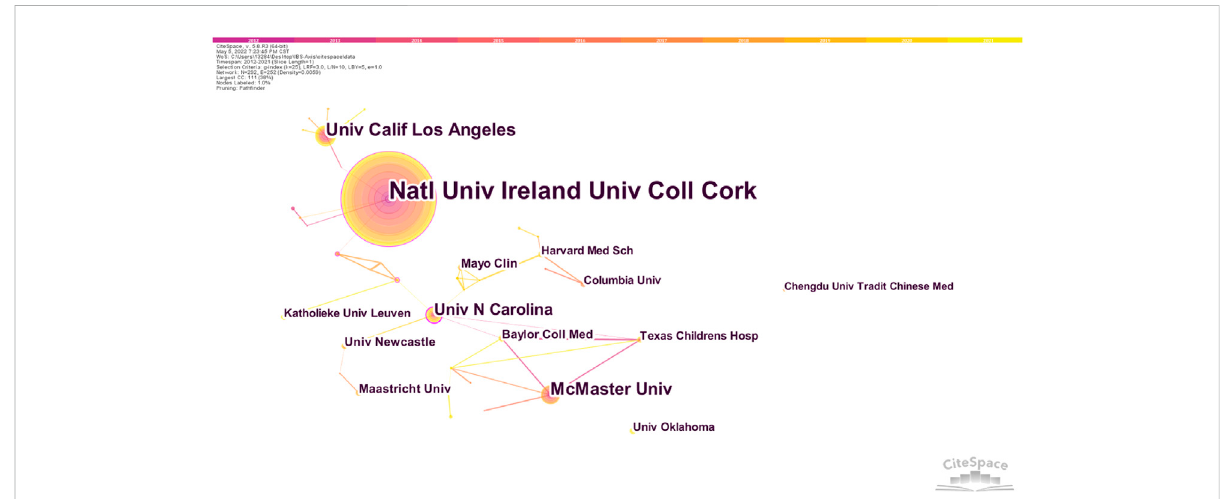
FIGURE 4 Institutions ’ collaboration network of research on IBS and the brain – gut